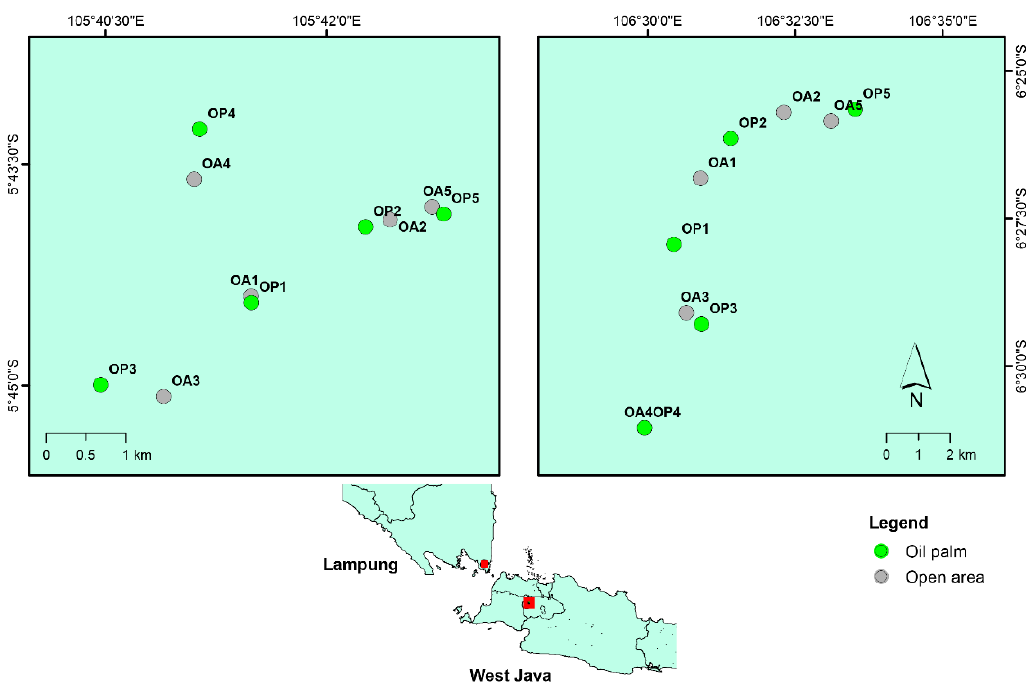
Figure 1. Map of the research area for insect observation in C. odorata in Bogor Regency, West Java ( right ) and South Lampung Regency, Lampung ( left ). The letters followed by numbers indicate site codes. The letters indicate land-use type: OA = open area, OP = oil palm; and the numbers (1–5) indicate villages as replications. Villages of Bogor Regency: 1 = Argapura, 2 = Bangun Jaya, 3 = Cantik Manik, 4 = Mekar Jaya, and 5 = Rengasjajar. Villages of South Lampung Regency: 1 = Klaten, 2 = Ngandri, 3 = Pasuruan, 4 = Ruang Tengah, and 5 = Tetaan.